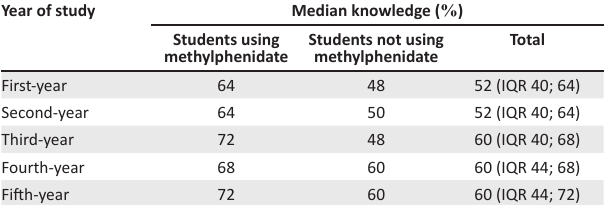
TABLE 3: Median knowledge ( % ) of students who use and those who do not use